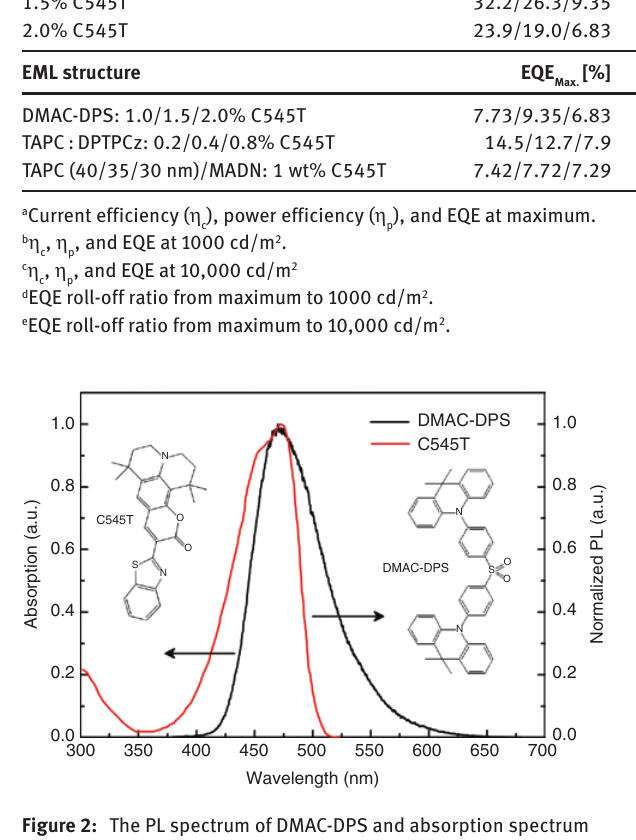
Figure 3B exhibits the transient PL decay curves of DMAC- DPS: x% C545T films with various doped concentrations.